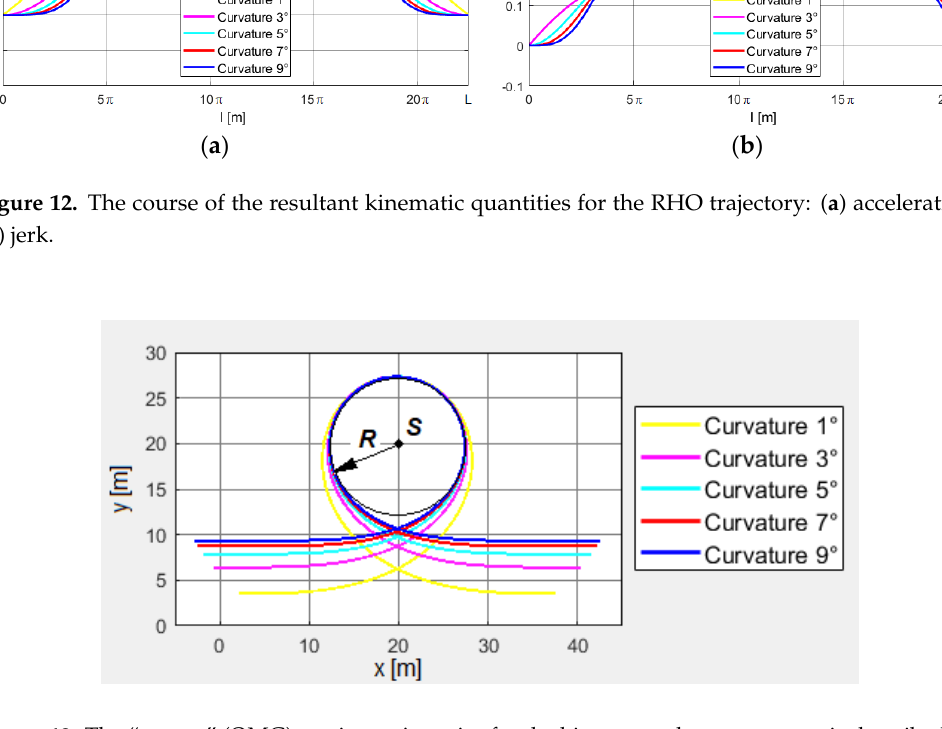
Figure 13. The “omega” (OMG) motion trajectories for the bi-curves whose curvature is described by the linear function as well as the third, fifth, seventh, and ninth degree